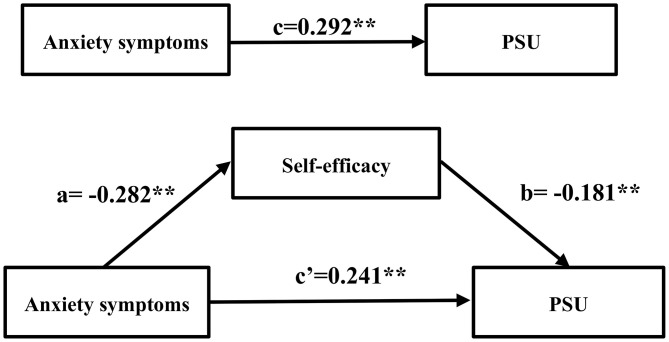
Model of the mediating role of self-efficacy between anxiety symptoms and PSU severity. **P < 0.01.